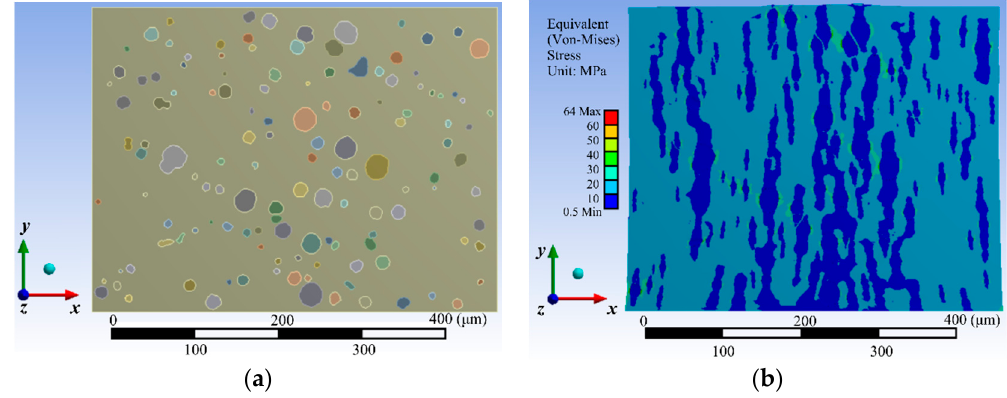
Figure 8. ( a ) Micro-scale model obtained by the proposed methodology from a ductile Cast Irons (DCI) micrography (Figure 6a); ( b ) Results from the Finite Element Analysis of the model in Figure 8a. Table 2. Stresses and relative errors obtained by the Finite Element Analysis (FEA) for the different methods